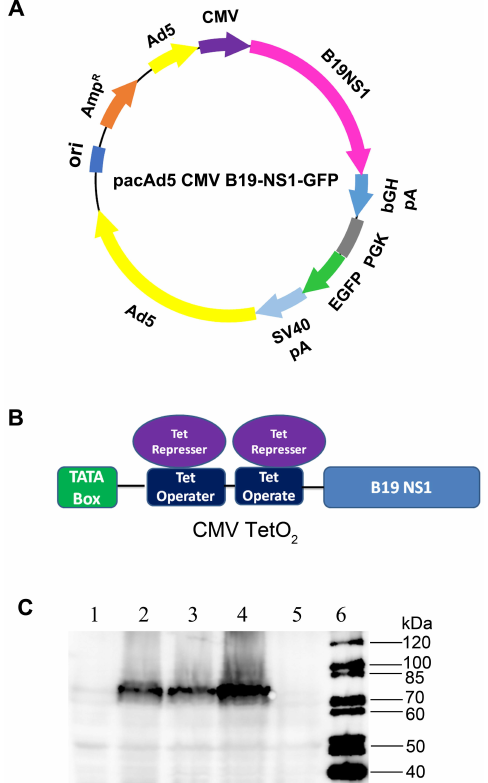
Figure 2. Modifications of the adenoviral shuttle vectors. ( A , B ) Modification of the CMV promoter. The transfer plasmid pacAd5 CMV-B19NS1-EGFP is diagrammed. Two tetracycline operator elements were inserted into the CMV promoter, which govern B19V NS1 expression. ( C ) Validation of the CMVTetO 2 promoter activity. HEK293 cells and T-REx-293 cells were transfected with pacAd5 CMV-B19NS1-GFP and pacAd5 CMVTetO 2 -B19NS1-GFP, respectively. At 48 h post-transfection, cells were collected for Western blotting using anti-strep antibody to check B19V NS1 expression. Lane 1: HEK293 cells control; Lane 2: HEK293 cells transfected with pacAd5 CMV-B19NS1-GFP; Lane 3: HEK293 cells transfected with pacAd5 CMVTetO 2 -B19NS1-GFP; Lane 4: T-REx-293 cells transfected with pacAd5 CMV-B19NS1-GFP; Lane 5: T-REx-293 cells transfected with pacAd5 CMVTetO 2 -B19NS1-GFP; Lane 6: protein